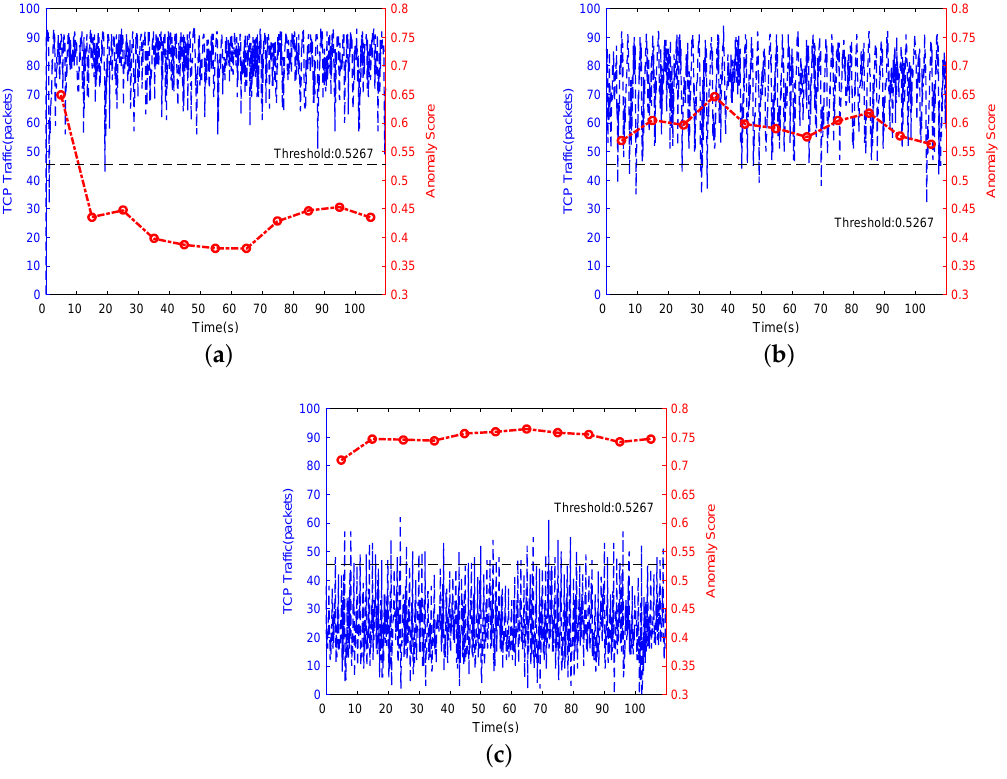
Figure 12. Distributions of TCP traffic and anomaly score between normal and LDoS attacks: ( a ) is under the state of normal, ( b , c ) are under LDoS attacks with R = 2 Mbps, P = 1 s, L = 0.1 s and R = 30 Mbps, P = 1 s, L = 0.1 s